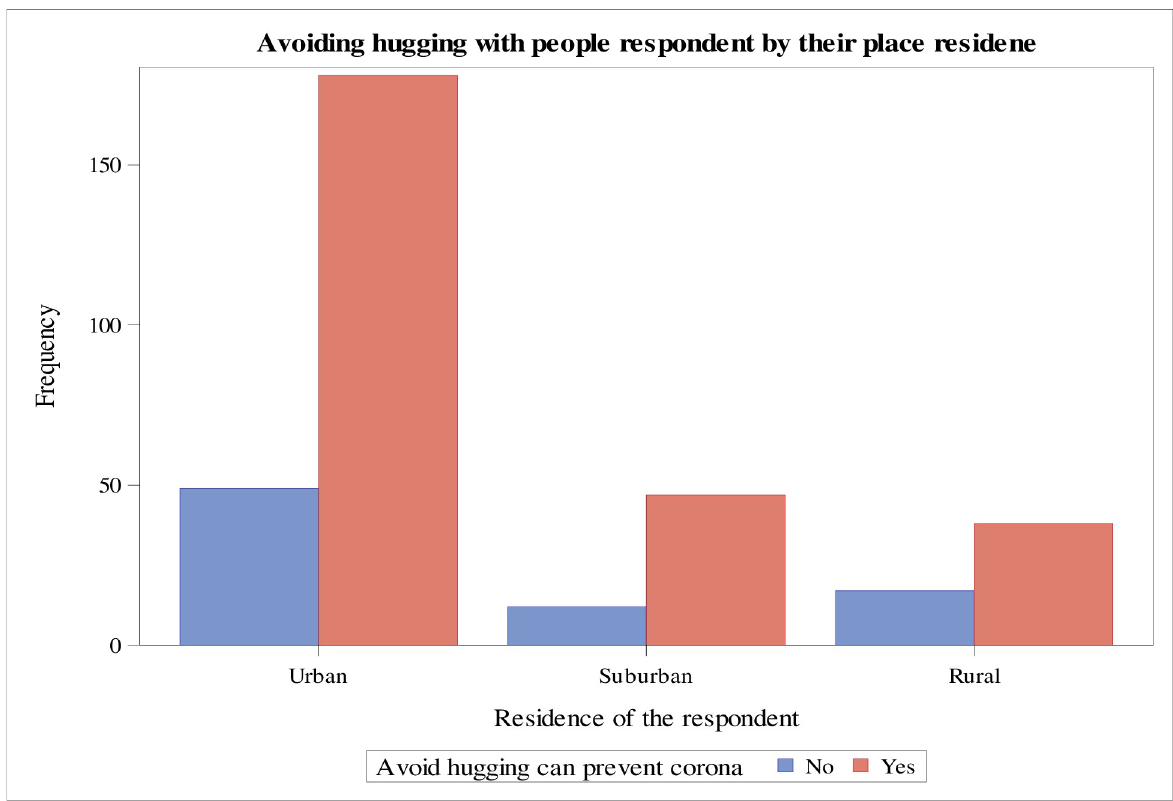
Fig 1. Respondents’ knowledge on avoiding hugging people for the protection of COVID-19 by their place of residence, Ethiopia, May 2020.